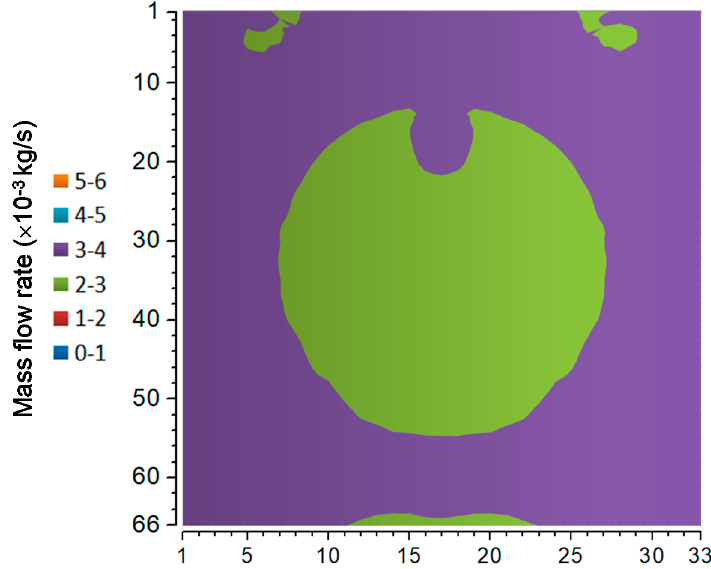
Figure 8. Distribution of the mass flow rates over the 33 × 66 channels when the perforated plate is installed.